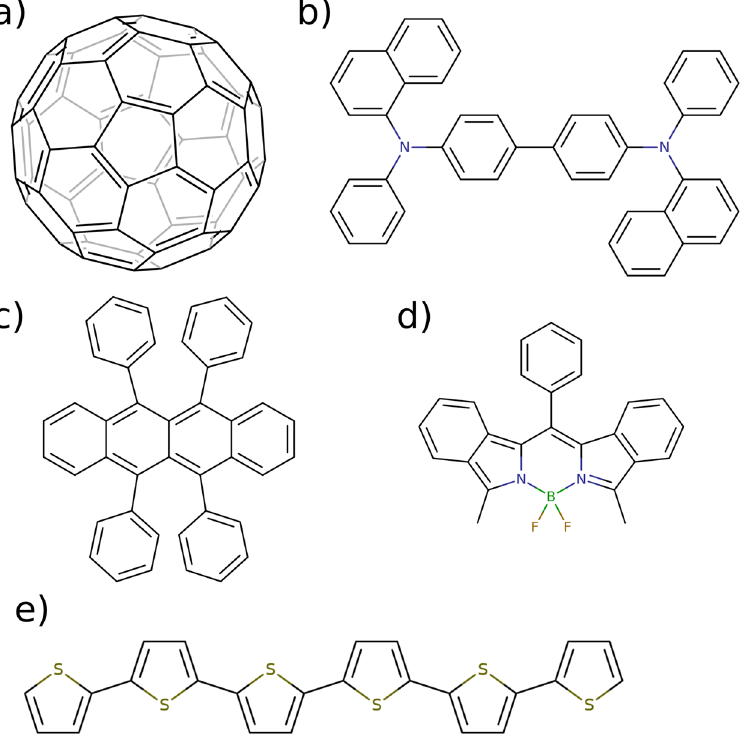
Figure 1. Molecular structures of ( a ) Acceptor molecule C60, ( b–e ) Donor materials NPB, rubrene, bDIP and